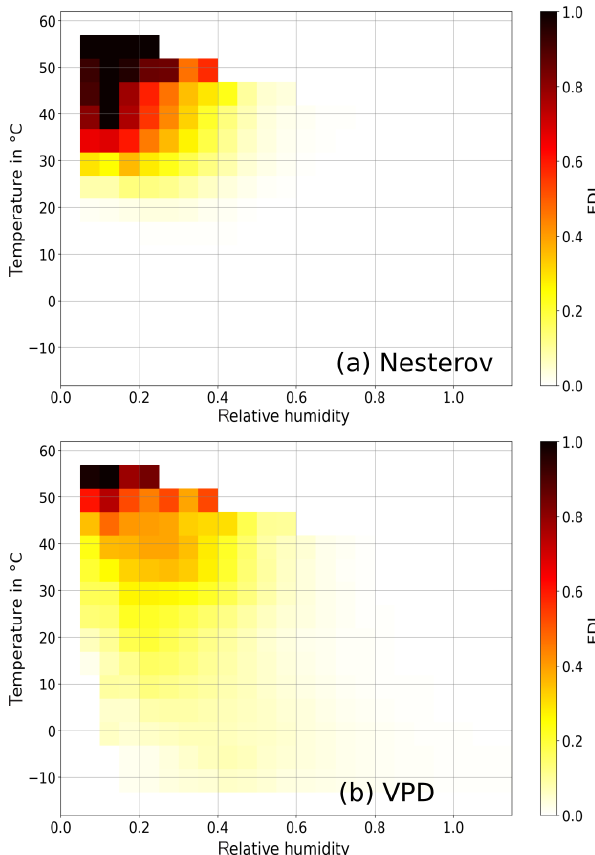
Figure 3. Dependence of the simulated fire danger index on monthly mean relative humidity and temperature for (a) the Nesterov-based index and (b) the VPD-based index. Both indices were calculated with monthly data for the years